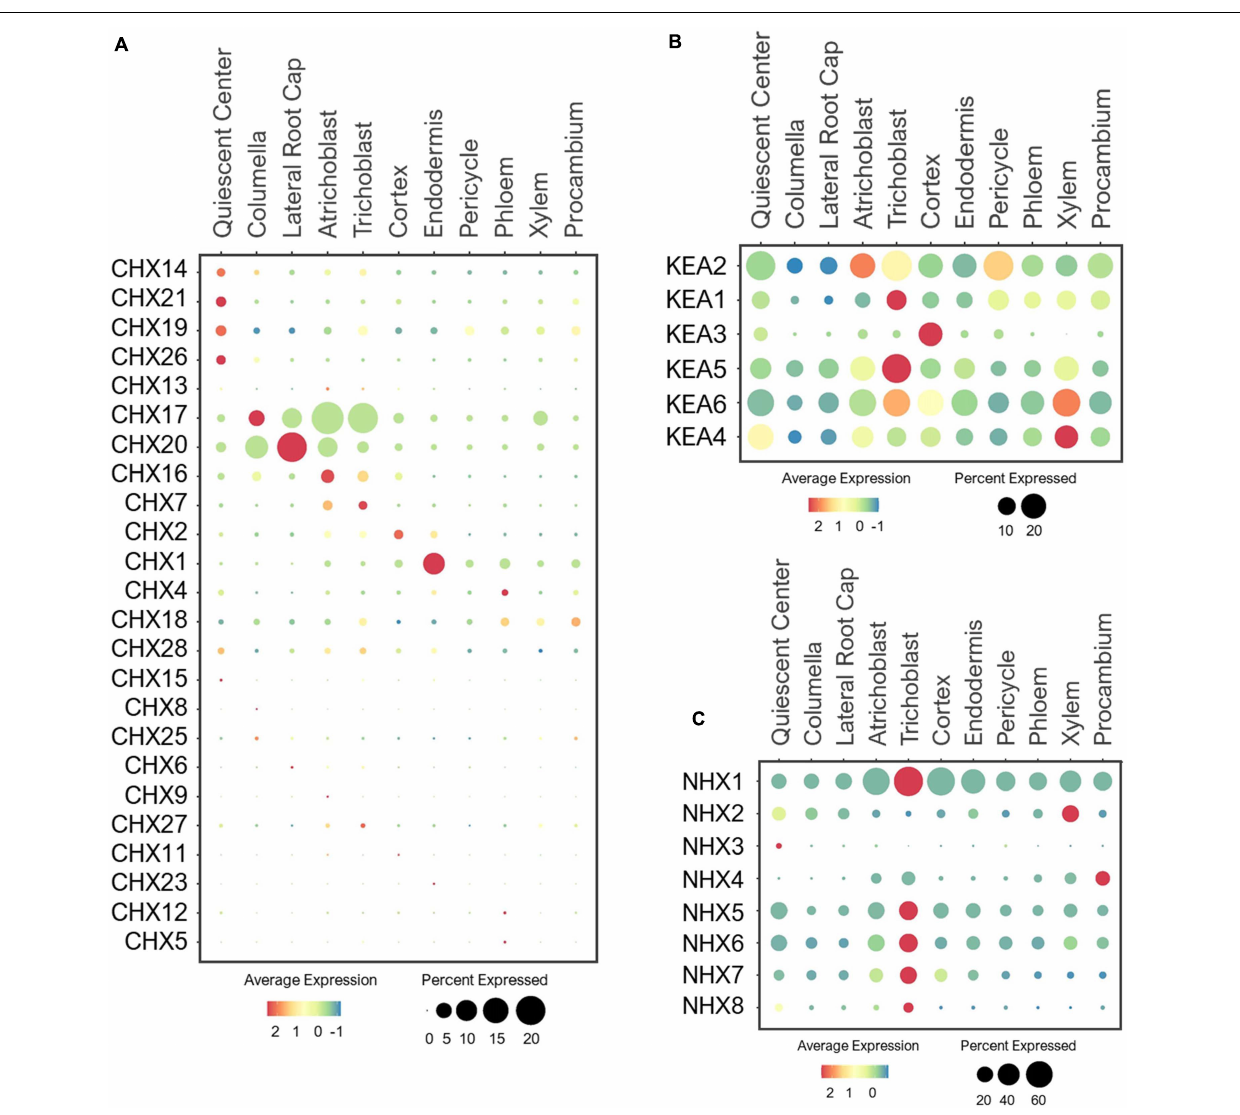
FIGURE 11 | Expression of the (A) CHX, (B) KEA and (C) NHX antiporters in Arabidopsis root single cells. In dot plots, the circle size represents the proportion (%) of cells expressing a given gene, and the color of scale bar represents the mean expression (natural log +1